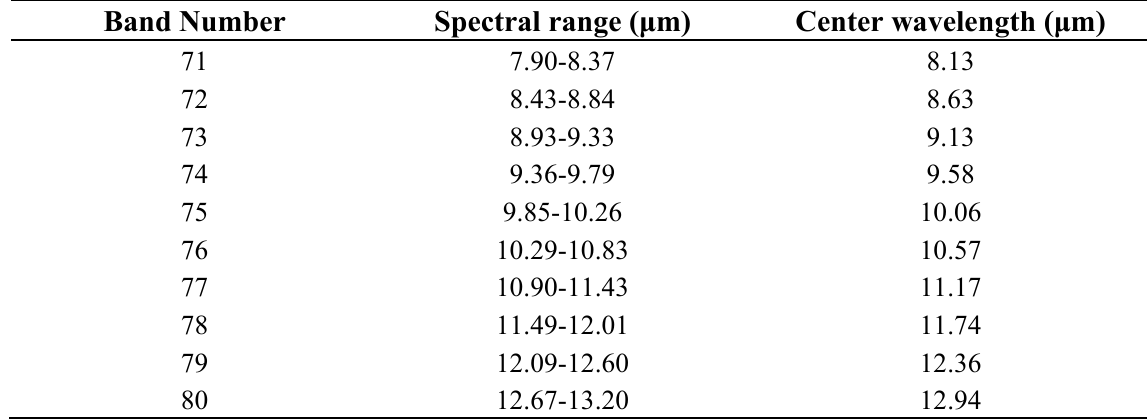
Table 2. The details of AHS Thermal bands from N0.71 to N0.80